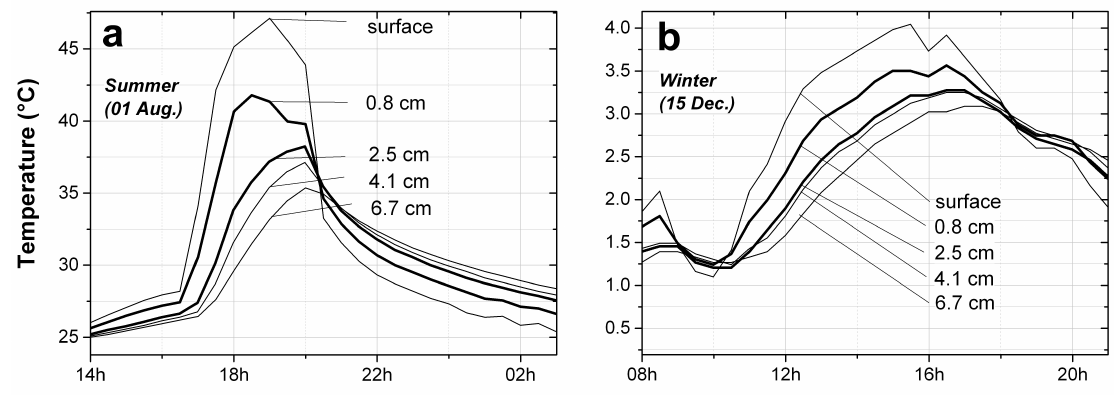
Figure 10. Temperature gradient in the depth of the wall. In bold, the temperatures used in the calculation. ( a ) In summer, a difference of 13.8 ◦ C has been measured between the surface and the first 7 cm of the wall; ( b ) In winter, the gradient is much smaller, on the order of 1.5 ◦ C in the first 7 cm of the